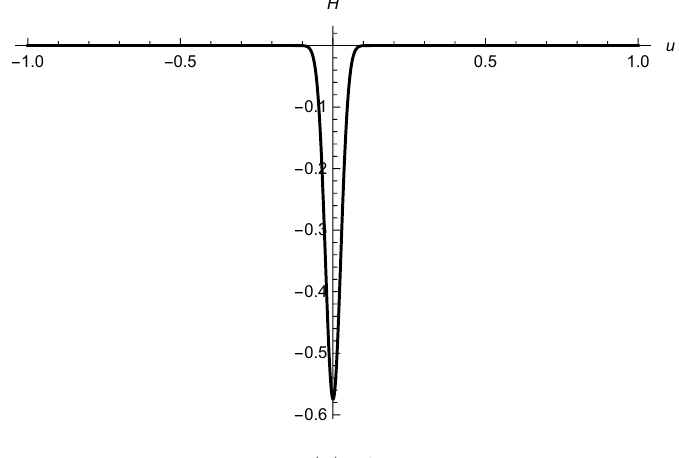
Figure 12. H 3 ( u ) when λ = 0.025.